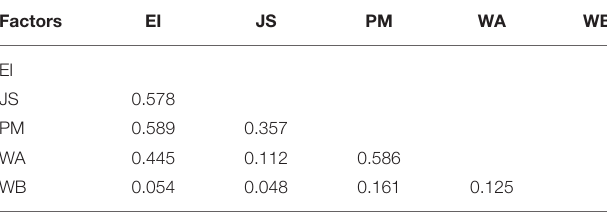
TABLE 5 | Discriminant validity results – HTMT. Factors